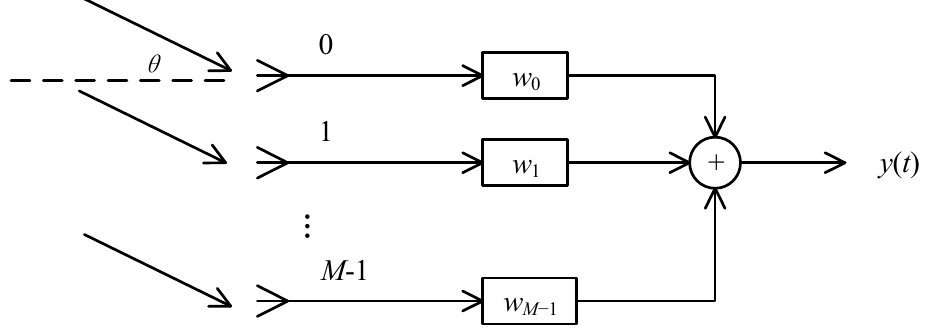
Figure 1. Structure of the narrowband beamformer.